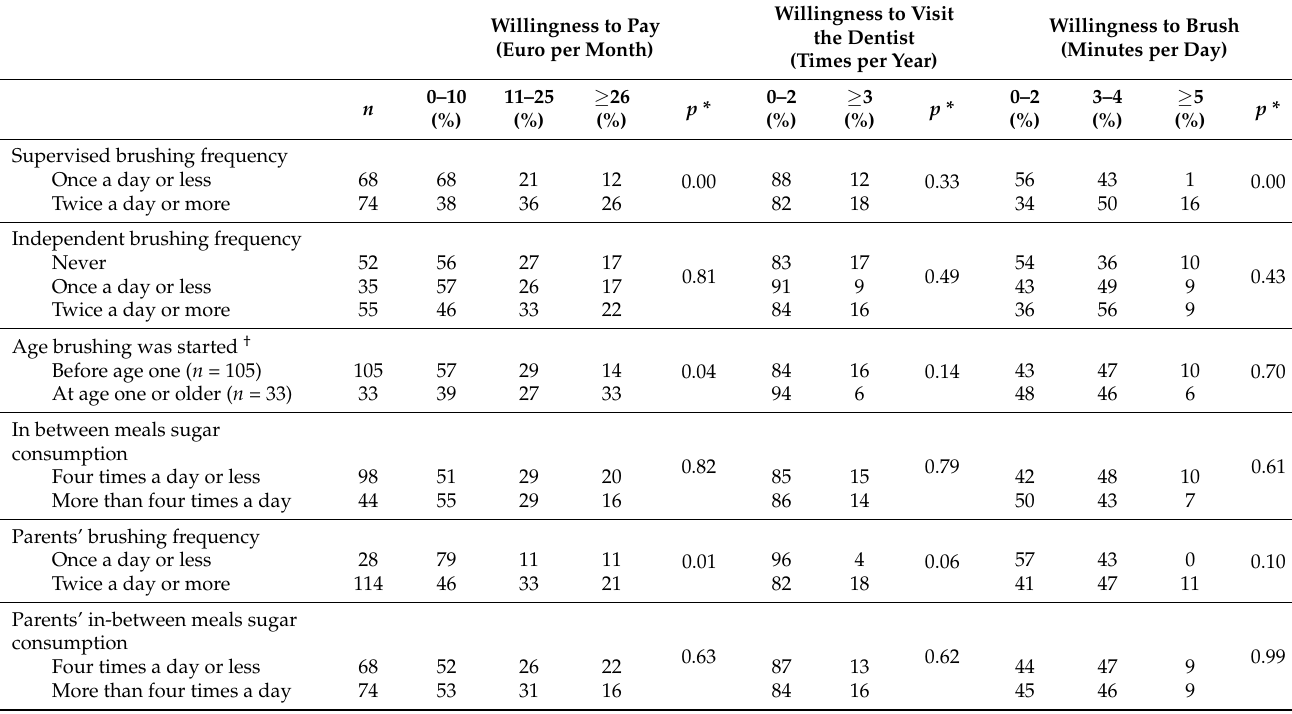
Table 5. Distribution (%) of children’s and parents oral hygiene behaviour by the willingness to invest in children’s oral